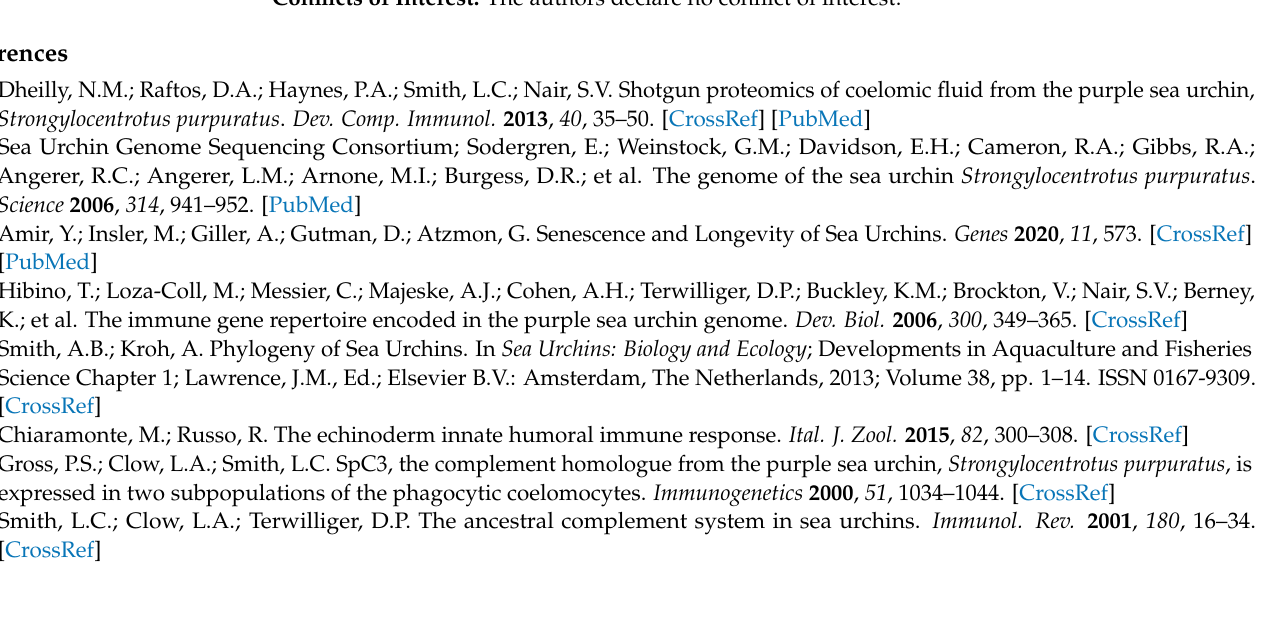
Table S5: Full LC-MS/MS analysis for F95-enriched protein hits from purple sea urchin coelomic fluid. Databases searched were: UniProt database CCP_Echinidea Echinidea_20210511 (38,194